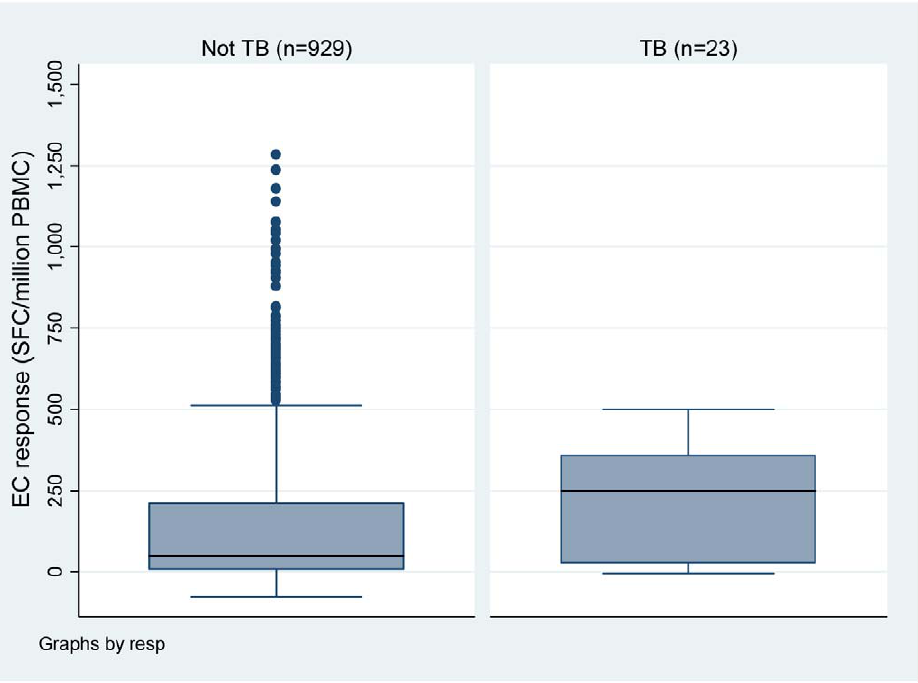
Figure 2. Box plots of EC ELISPOT response (SFC/million PBMC) at baseline by TB status in follow-up.